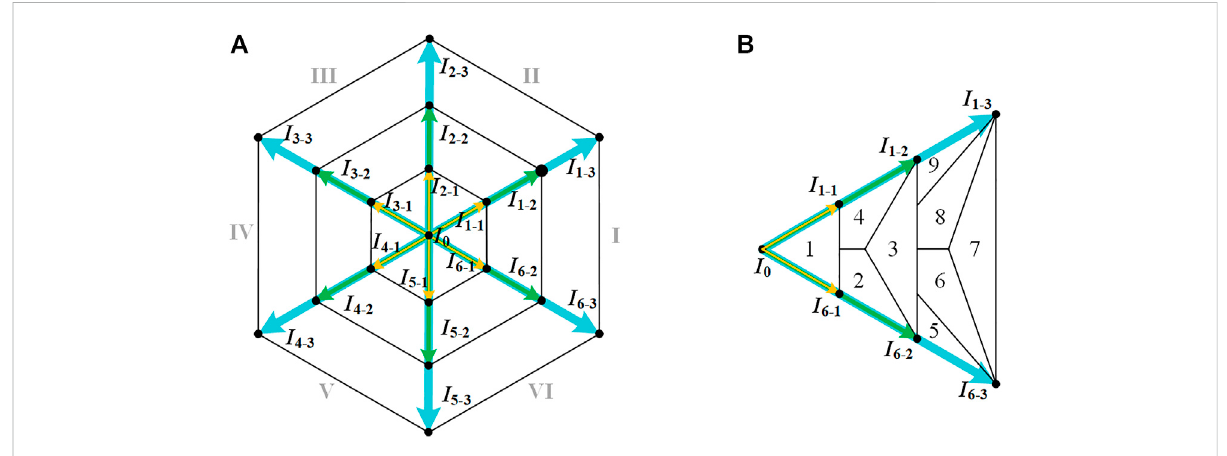
FIGURE 8 (A) Overall space vector diagram. (B) Region divisions of Sector I.